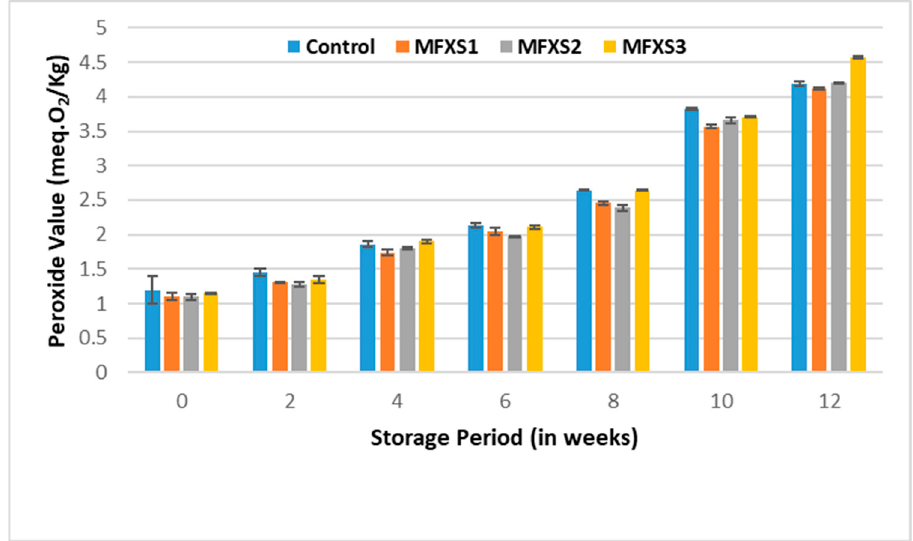
Figure 6. Peroxide values of mayonnaise samples during cold storage (7 ± 2 °C). Control sample: